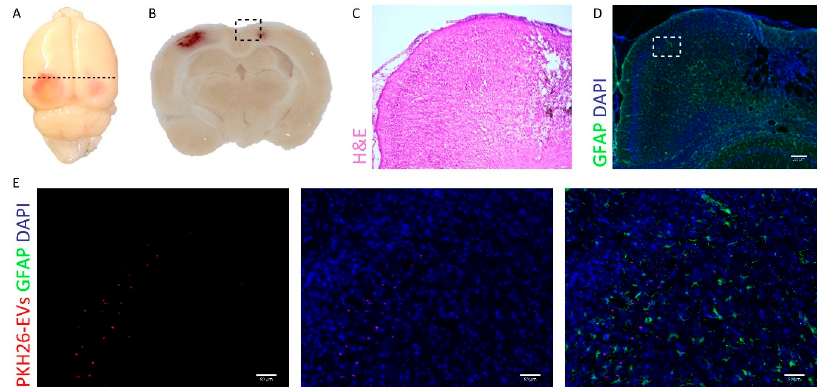
Figure 1. PKH26-labeled extracellular vesicles (EVs) accumulate in lesion sites in brains of the SBH/y model of cerebral small vessel disease (CSVD). Representative images of brain derived from SBH/y-DS rats following a single administration of PKH26-labeled EVs ( A ). Dashed lines represent the coronal section presented in ( B ). 5× magnification of the injured area is presented using H&E ( C ) and GFAP immunostaining ( D ). Scale bar = 200 µm. A magnification of the inset in ( D ) is presented in ( E ). PKH26 labeled EVs are shown in red. Scale bar = 50 µm.